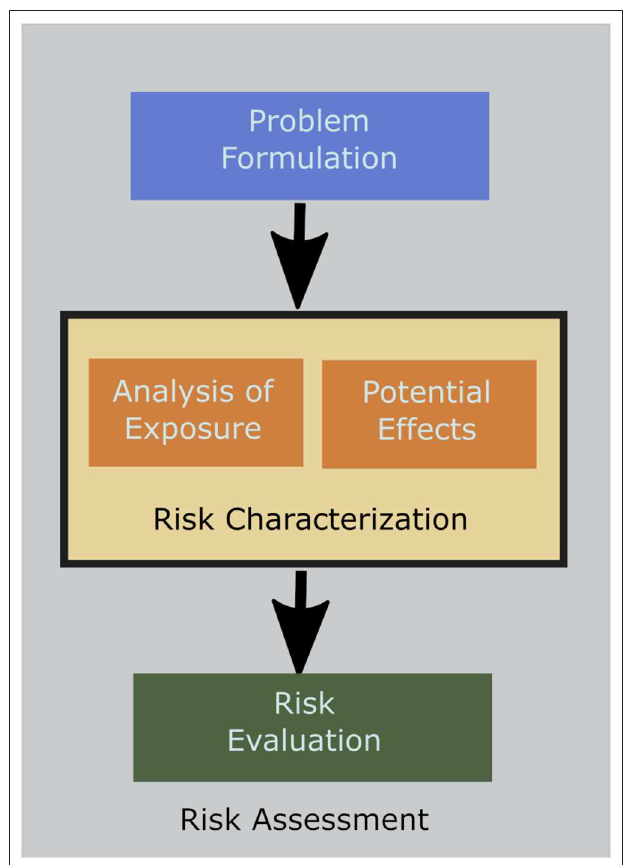
FIGURE 2 | This figure provides details of the broad steps used in the risk assessment process. All risk assessments start with problem formulation to develop the hypotheses that need to be tested. Once problem formulation is completed risk characterization is conducted with analysis of exposure and testing to determine the potential effects of the exposure. Data from the risk characterization studies are used in the risk evaluation process. This figure was adapted from Wolt et al.